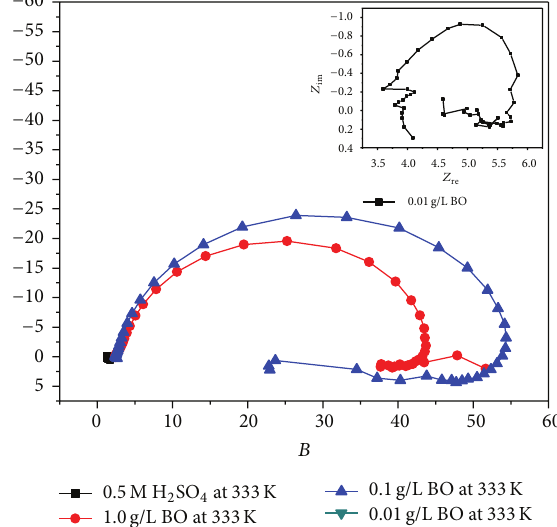
Figure 8: Nyquist plot for pipeline steel in 0.5 M H 2 SO 4 with and withoutdifferentconcentrationsof Brassicaoleracea extractat333 K.